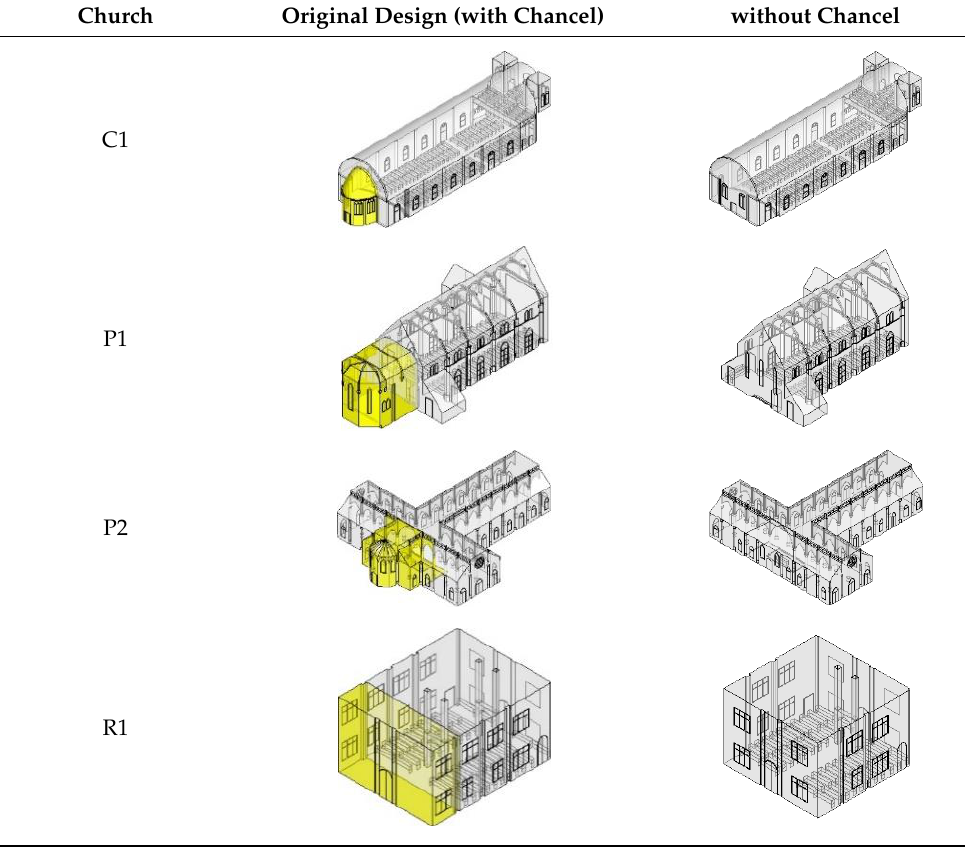
Table 3. The four churches and their modified chancels’ availability (Simulation 1).